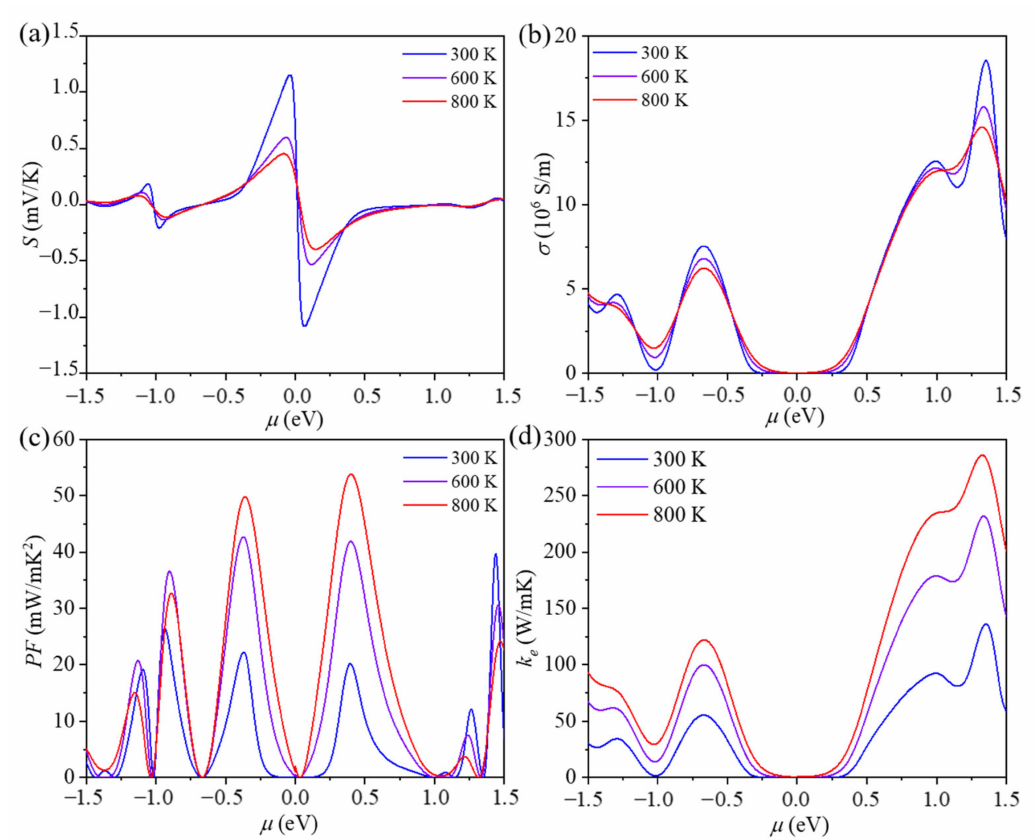
Figure 4. ( a ) Seebeck coefficient ( S ), ( b ) electrical conductivity ( σ ), ( c ) power factor ( PF ), and ( d ) electronic thermal conductivity ( k e ) of ID-GY as a function of chemical potential µ ,